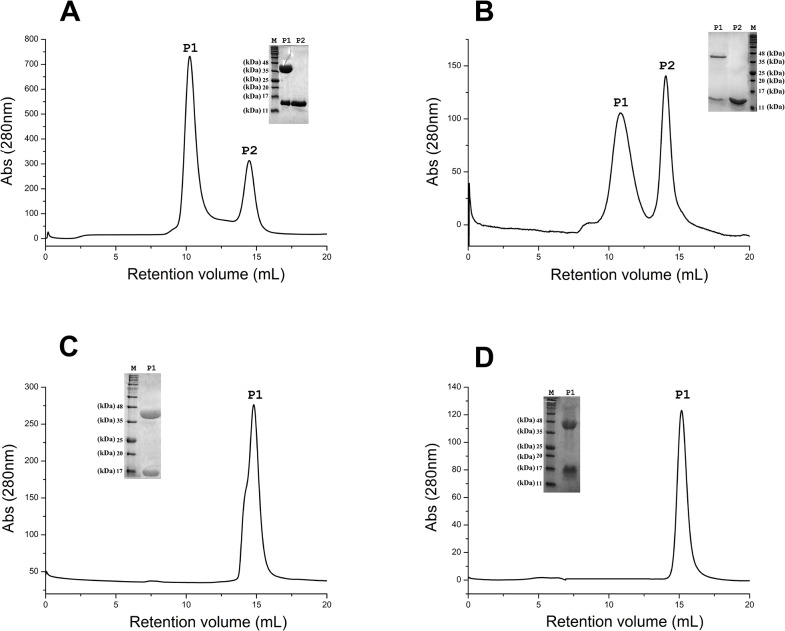
Detection of Cul3-KCTDs binding by gel filtration.Gel filtration elution profiles of KCTD6BTB (A), KCTD11BTB (B), KCTD12BTB (C), and KCTD15BTB(D) after their mixing with Cul3NTD. The insets report the SDS-PAGE analysis of the peaks.